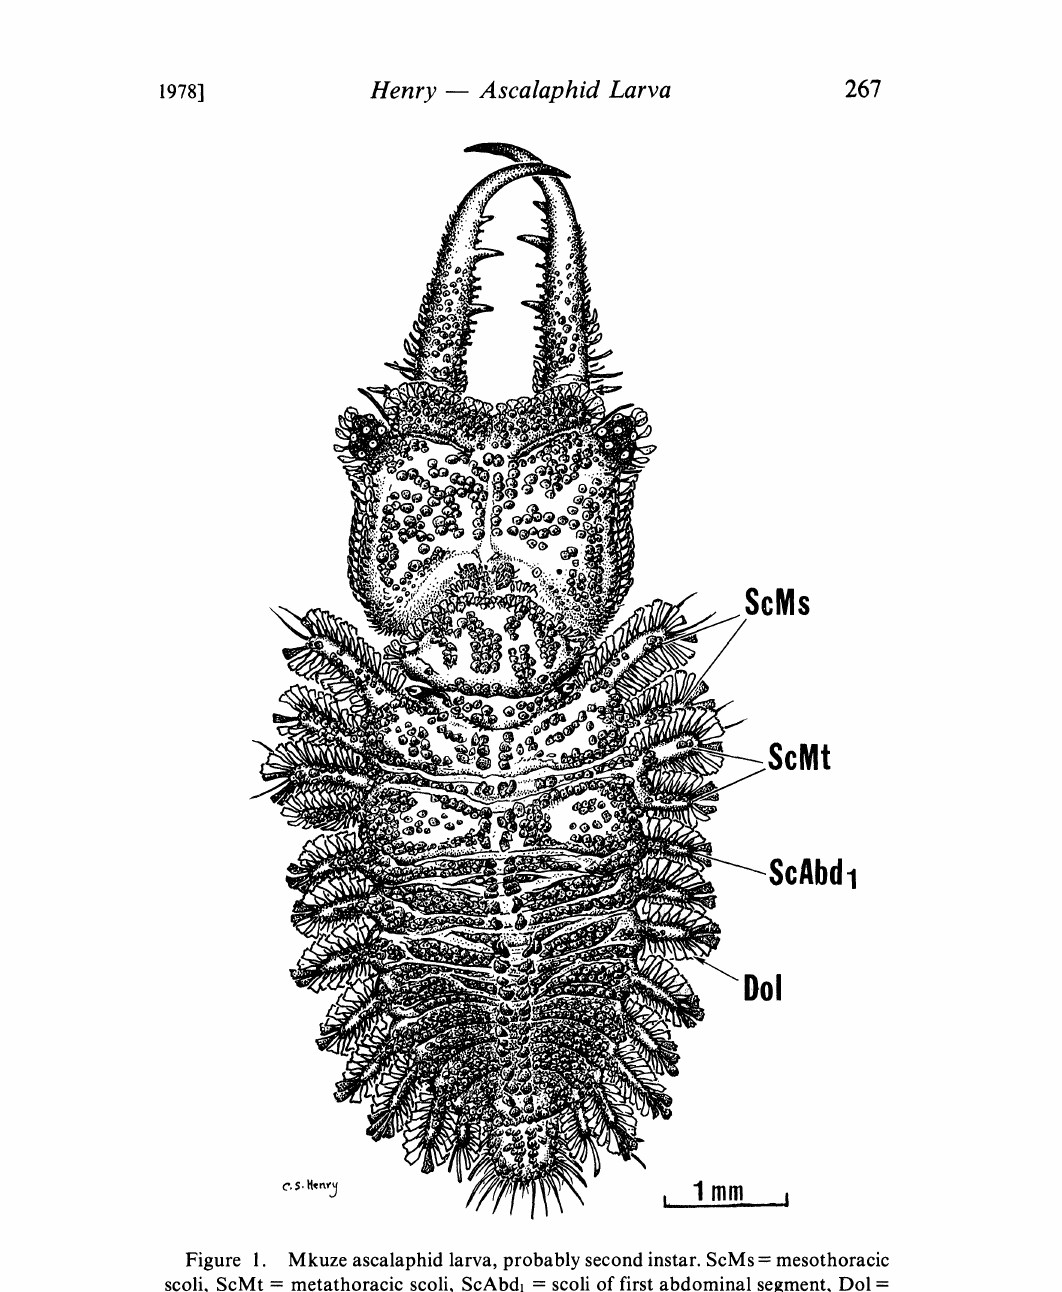
Figure 1. Mkuze ascalaphid larva, probably second instar. ScMs mesothoracic scoli, ScMt metathoracic scoli, ScAbdl scoli of first abdominal segment, Dol dolichasterine